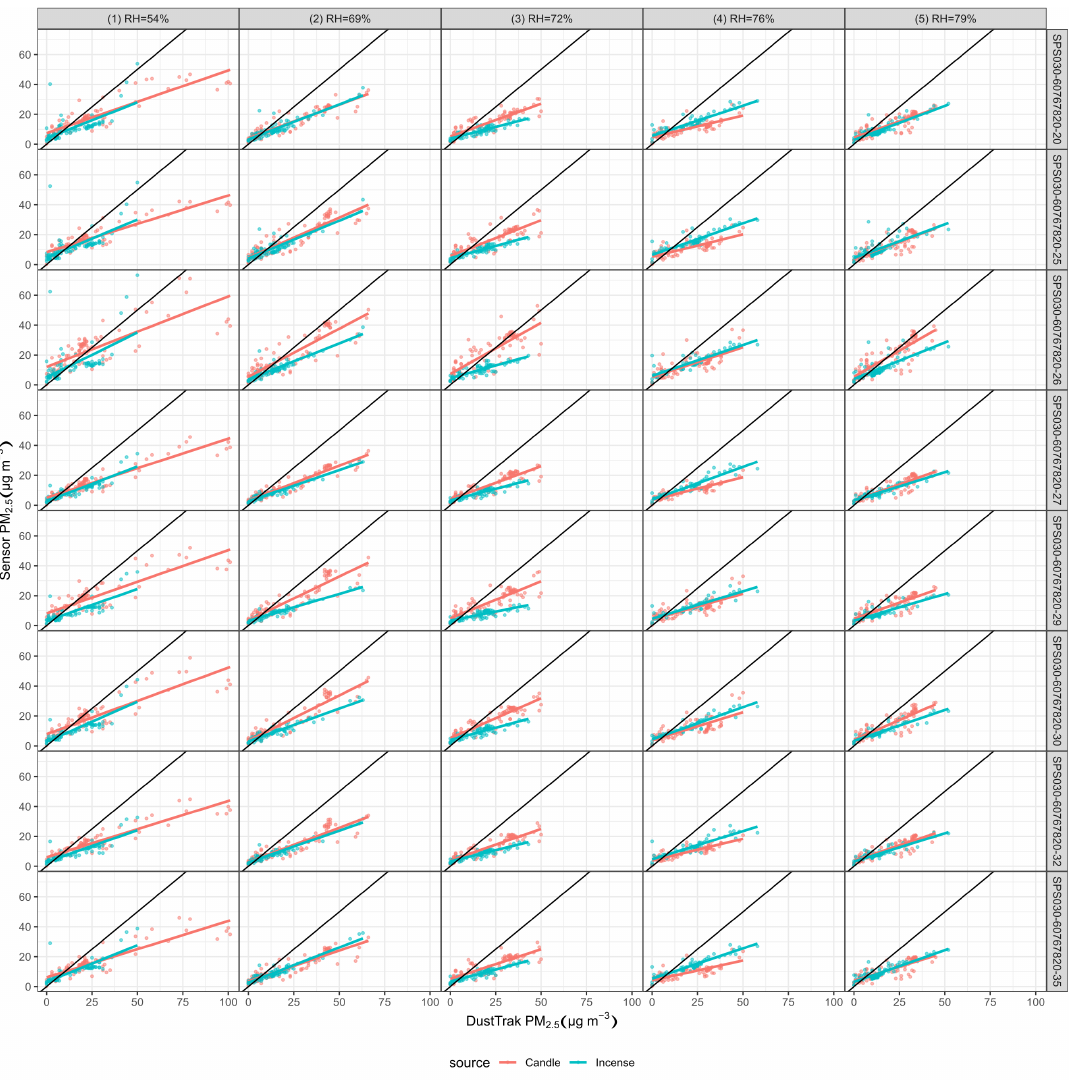
Figure A8. Comparison and linear regression of the Sensirion SPS030 with the DustTrak (x = DustTrak, y = sensors) during the five experiments for peaks and stable concentrations of PM generated using incense and candle. The black line is x =